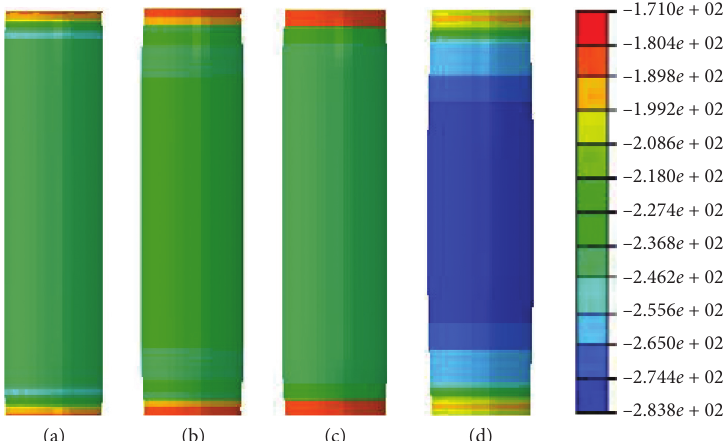
Figure 9: The longitudinal stress contour maps of the carbon steel tube. (a) Point A. (b) Point B. (c) Point C. (d) Point